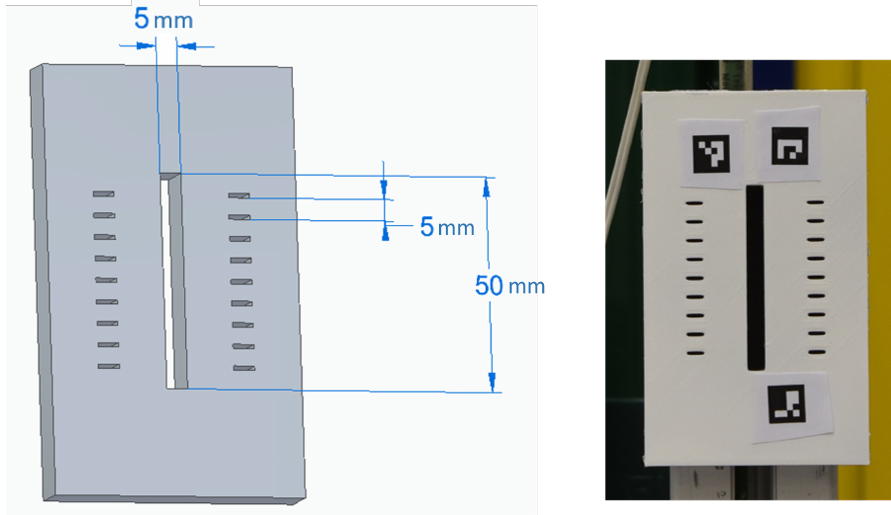
Figure 24. A reference target was produced in FDM 3D printing with a built-in central groove of 5 mm (nominal design value)